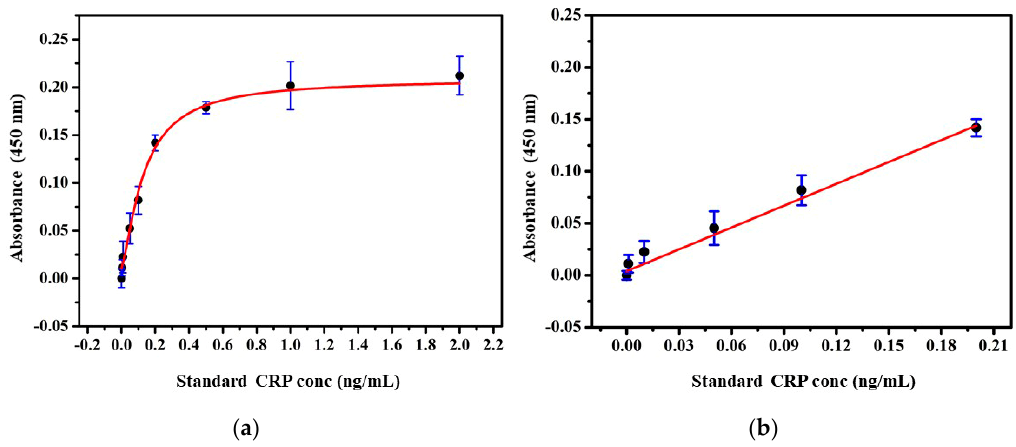
Figure 4. ( a ) Standard graph for detection of CRP based on developed 6XHis nanoprobe. Error bar indicates the standard deviation of four repeated experiments (black dots) and ( b ) along with the fitted standard curve.